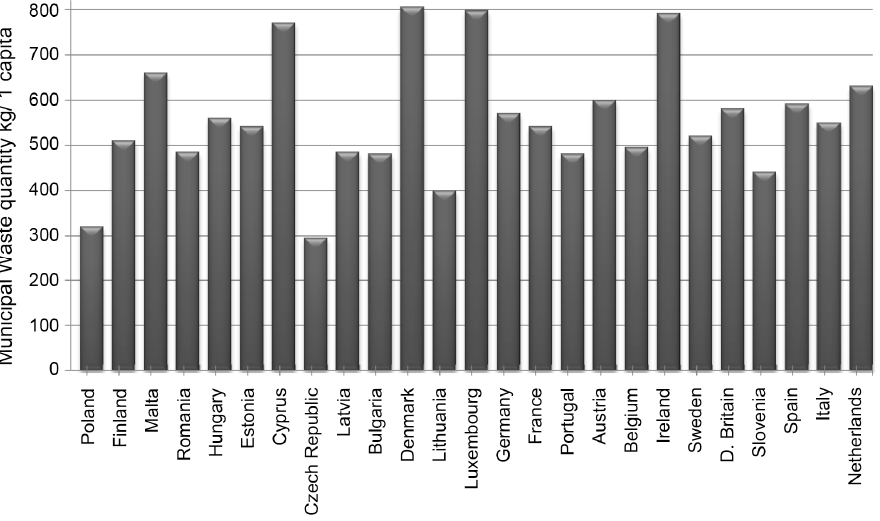
Fig. 1. Municipal waste generation in Europe in 2007, kg per capita (Waste statistics... 2010)